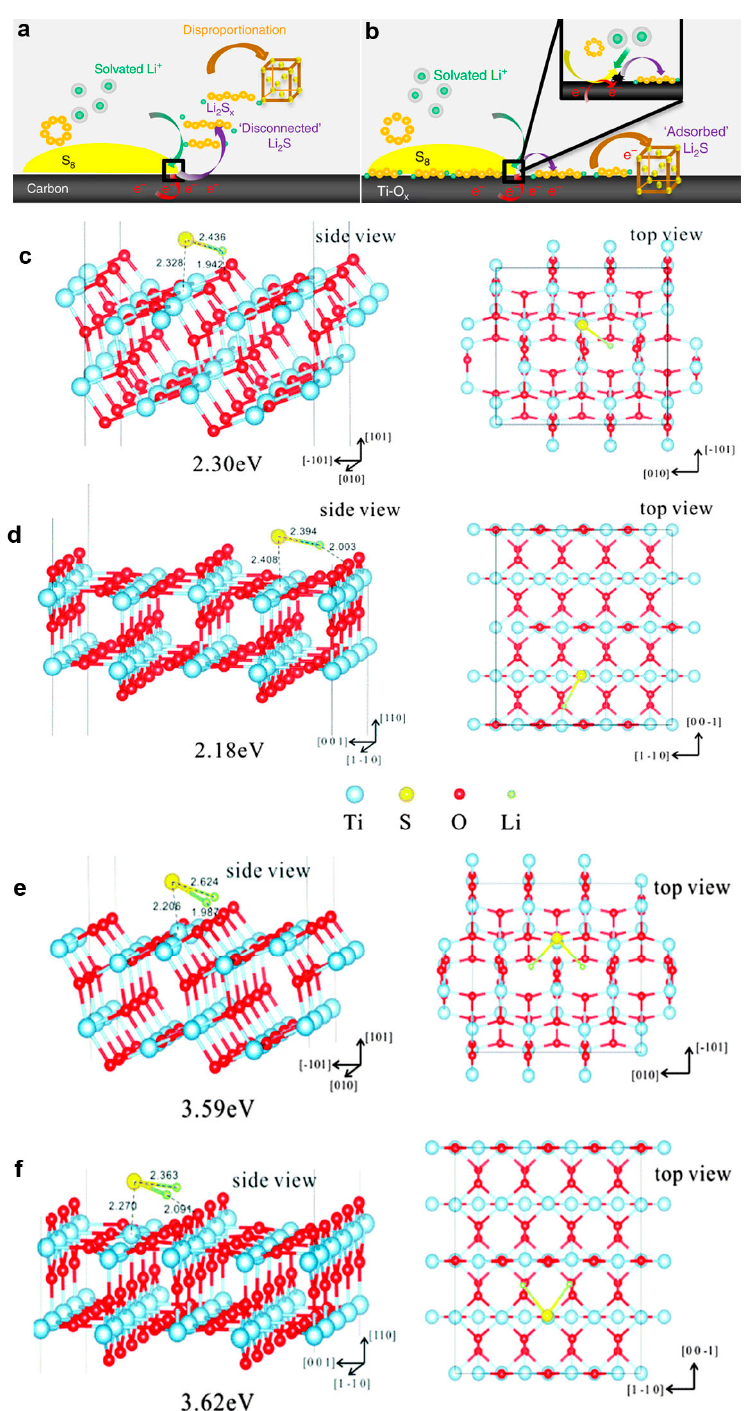
Figure 7. The interaction between sulfur or lithium polysulphides and electrodes. ( a ) On reduction of S 8 on a carbon host, Li 2 S X desorb from the surface and undergo solution-mediated reactions leading to broadly distributed precipitation of Li 2 S; ( b ) On reduction of S 8 on the metallic polar Ti 4 O 7 , Li 2 S X adsorb on the surface and are reduced to Li 2 S via surface-mediated reduction at the interface (reprinted from [135] with permission, Copyright Nature Publishing Group, 2014); Adsorption configuration of ( c , d ) Li–S* and ( e , f ) Li 2 S on the ( c , e ) anatase-TiO 2 (101) surface and ( d , f ) rutile-TiO 2 (110) surface (Reproduced with permission from [136], Copyright The Royal Society of Chemistry,